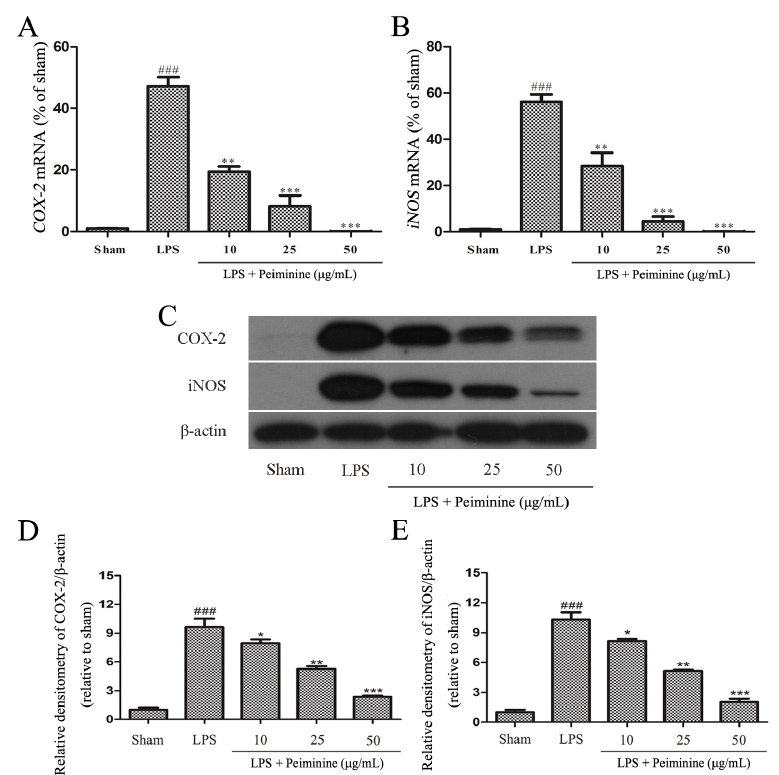
Figure 5. Peiminine inhibits the LPS-induced inflammatory response in BV-2 cells. BV-2 cells were pretreated with peiminine (10, 25 or 50 μ g/mL) for 1 h and then stimulated with LPS for 4 h. ( A , B ) The expression of the iNOS and COX-2 mRNAs was examined by quantitative real-time PCR ( n = 3); ( C – E ) levels of the iNOS and COX-2 proteins were measured by Western blotting ( n = 3). ### p < 0.001 compared to the sham group, * p < 0.05, ** p < 0.01 and *** p < 0.001 compared to the LPS group.